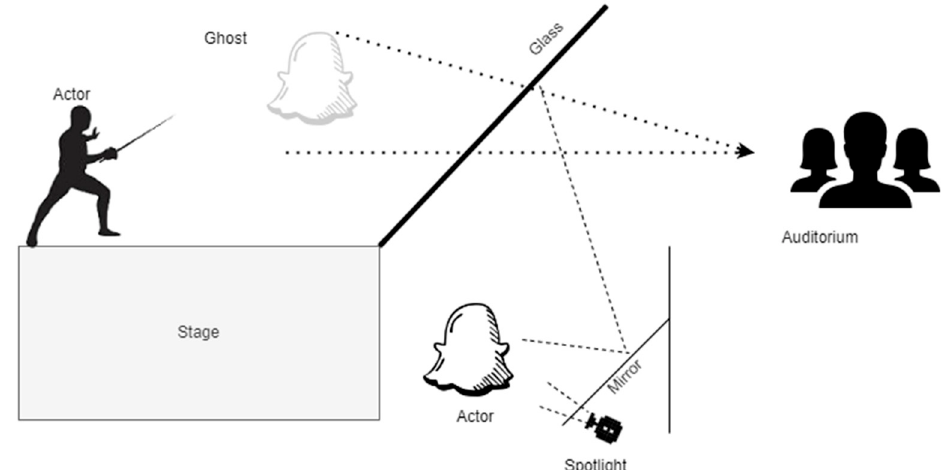
Figure 1. The schematic illustration of stage setup for Pepper’s Ghost.